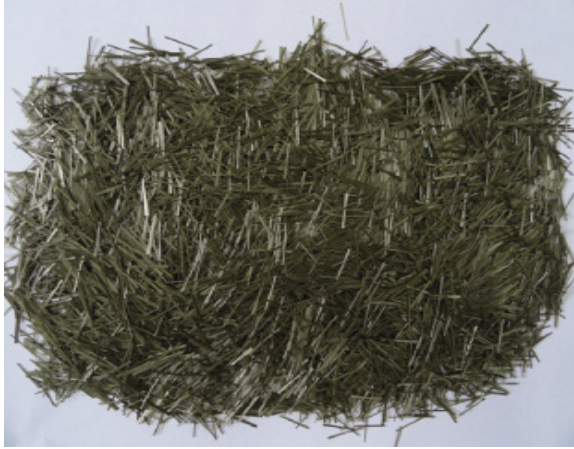
Figure 2. Basalt Fibers [30] with Elsevier permission. Table 1. Physical Properties BFs.